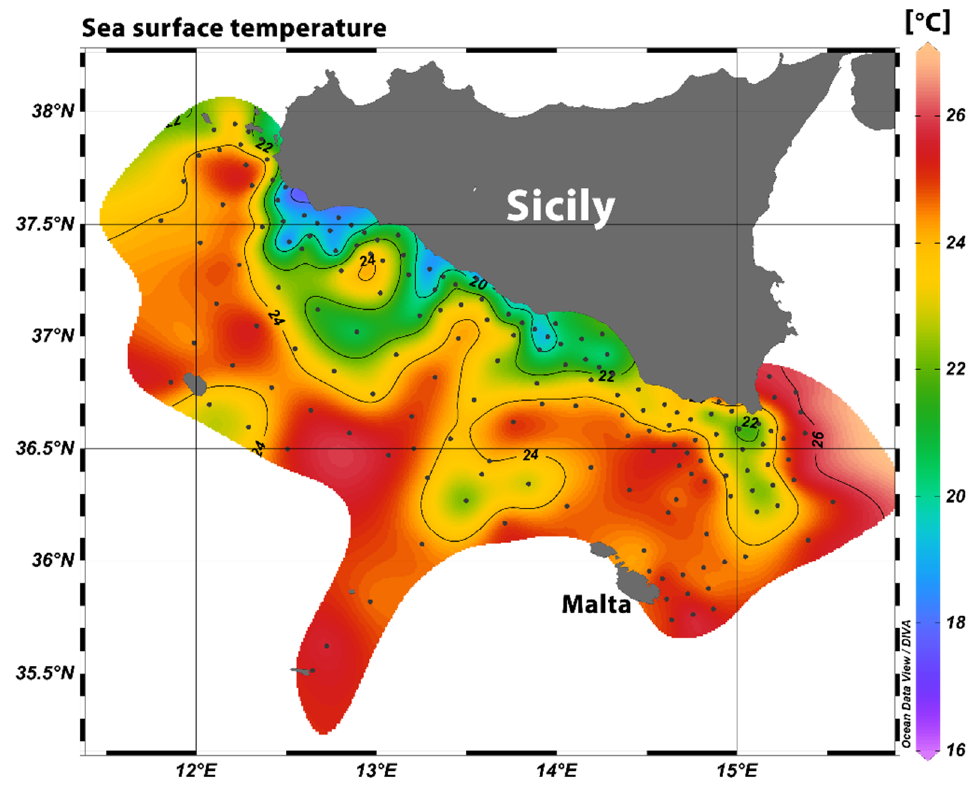
Figure 2. Map of the Sicilian Channel showing the surface temperature (units in °C) in the study area. Higher larval densities were recorded in area 3, 5 and Malta, while few larvae were found in areas 1, 2 and 4 as it is shown in Figure Table 1. Environmental conditions. Mean (± sd) temperature, salinity and fluorescence within the first 20 m. Different superscript letters after temperature values indicate statistically significant dif- ference between pairs of areas (permutational pairwise t test, p -value < 0.05).